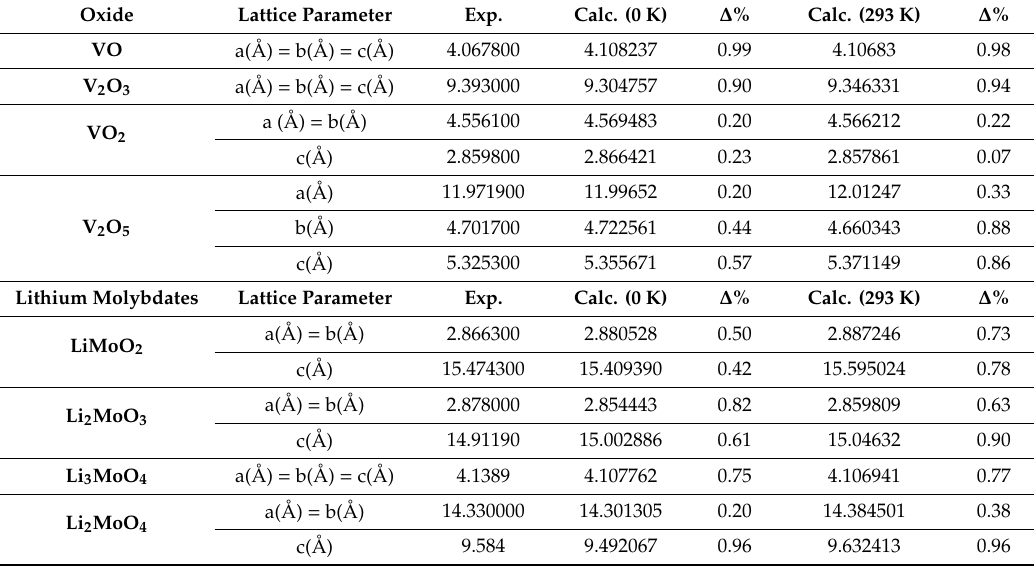
Table 2. Comparison of calculated (calc.) and experimental (expt.) lattice